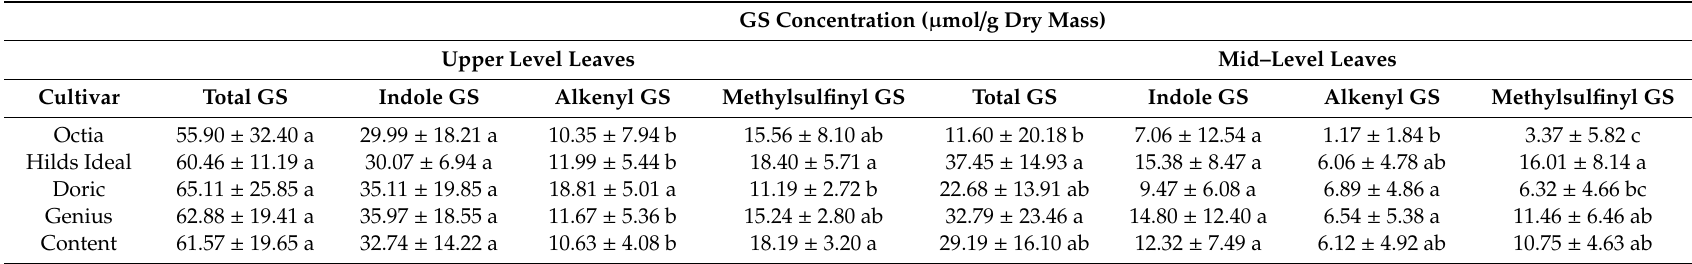
Table 3. Mean concentrations of total glucosinolates and main glucosinolate subgroups (indole, alkenyl and methylsulfinyl glucosinolates (GS)) of five Brussels sprout cultivars at two leaf levels ( ± SD). Within a column, means of same leaf level with di ff erent letters are significantly di ff erent (generalised linear model (GLM), p ≤